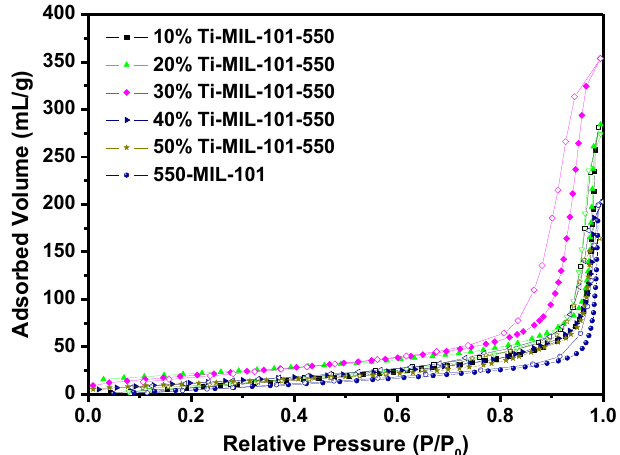
Figure 2. Nitrogen adsorption isotherms of various samples.